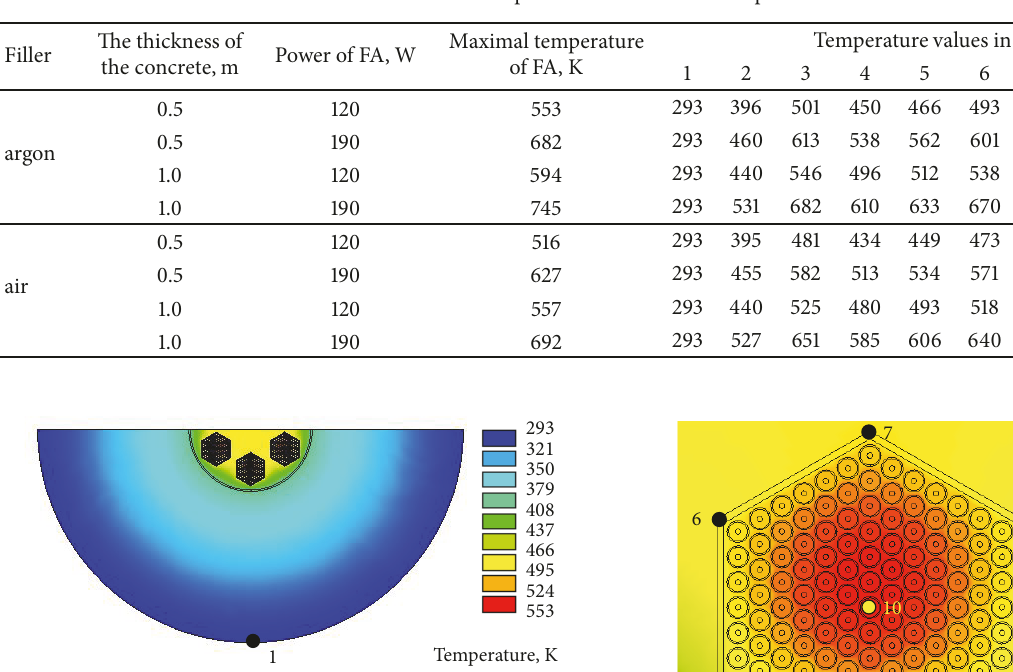
Table 4: Value of temperature in the calculation point of the model.